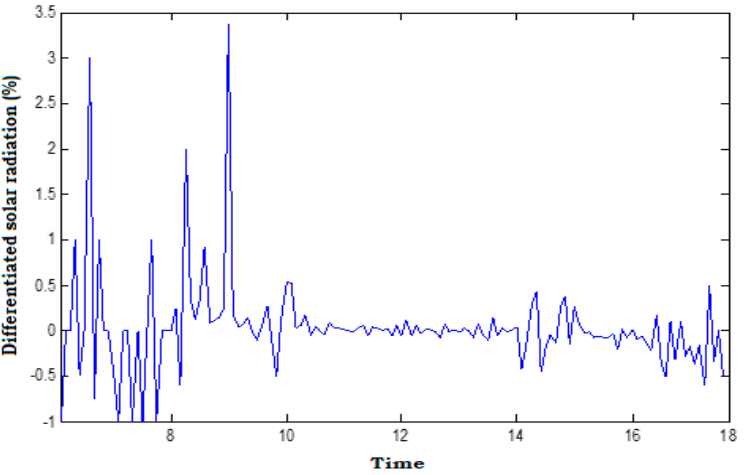
Figure 3. Solar radiation evolution for a winter day (after relative differentiation).